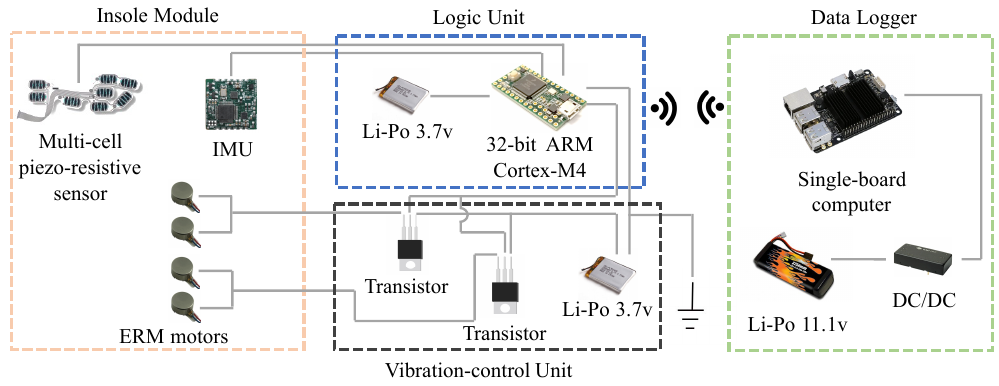
Figure 1. ( a ) The proposed wearable biofeedback system (WBS) consists of two insole modules, a data logger, and a vibration-control unit; ( b ) The insole module includes a multi-cell piezo-resistive sensor, an IMU, and four eccentric rotating mass (ERM) motors, all embedded in the insole; ( c ) The vibration-control unit includes a control board and a Li-Po battery. The instrumented insoles are fitted inside regular sneakers; the logic unit is housed inside a customized 3D-printed enclosure and attached to the wearer’s shoes with a clip; and the vibration-control unit is attached to the user’s distal shank through Velcro straps.